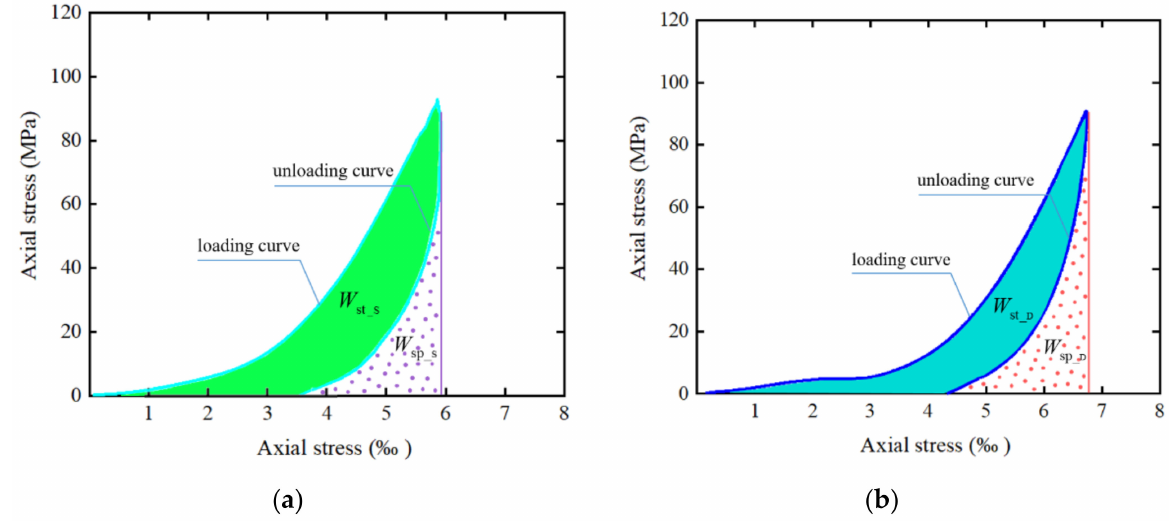
Figure 7. Test curves of uniaxial loading and unloading. ( a ) From entrance section. ( b ) From deep-buried